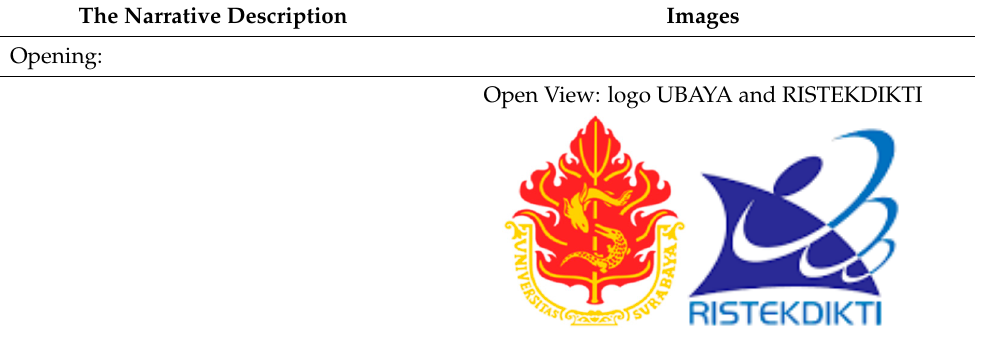
Table A2. The Educational Video Script. The antibiotic educational video narrative “Mengenal antibiotik dan resistensi antibiotik”.